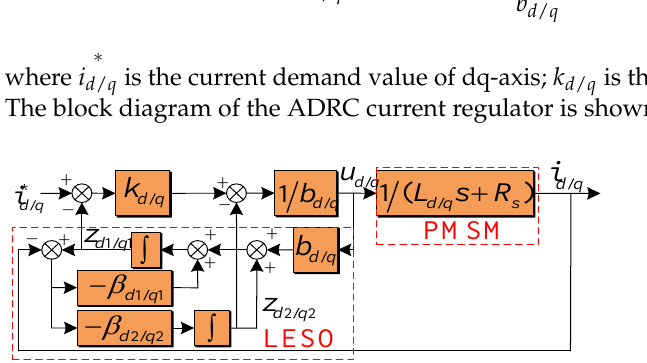
Figure 1. ADRC current regulator.